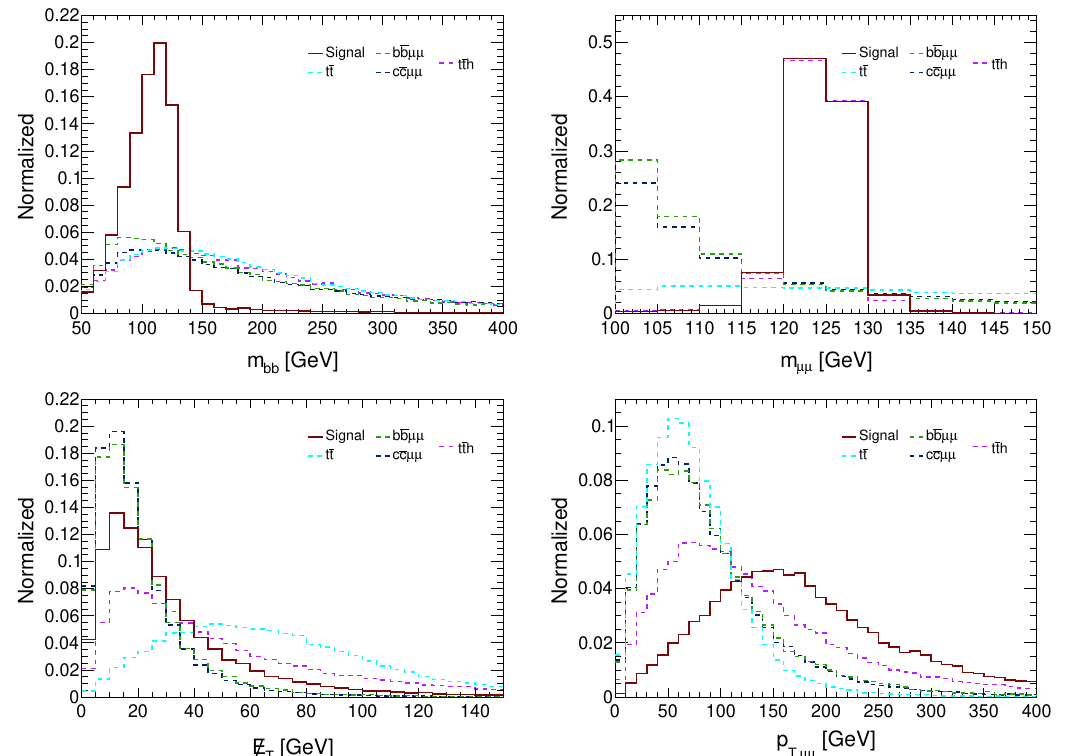
Figure 14 . Normalized distributions of m bb , m µµ , /E dominant backgrounds after the acceptance cuts and the generation level